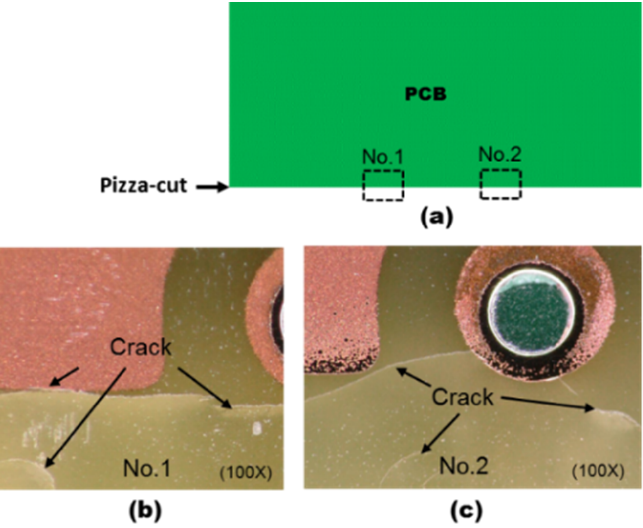
Figure 12. Observation of cracks in a PCB after de-paneling using an Olympus BX51 microscope at 50 × magnification of: ( b ) location No. 1 and ( c ) location No. 2, as marked in ( a ), which is a horizontal cross-section of a PCB with a pizza cutter de-panel.